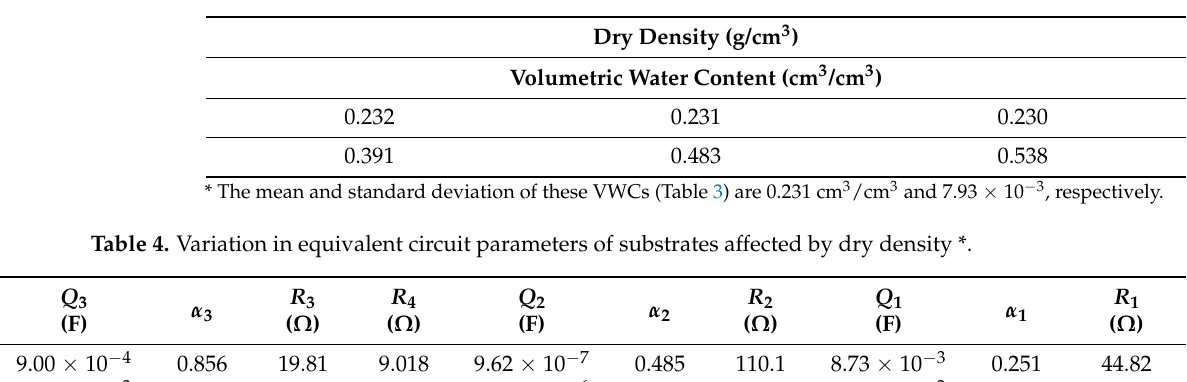
Figure 6. Impact of changes in dry density on measured complex conductivity of substrate. ( a ) Nyquist plots; ( b ) magnitude spectra; ( c ) phase spectra; ( d ) in-phase conductivity spectra; ( e ) quadrature conductivity spectra. For the spectra marked by different colors, the variable dry densities are provided in ( a ), while the related volumetric water contents (Table 3) are considered to be nearly equal. The frequency range is from 20 Hz to 2 MHz. Table 3. Dry densities of a typical set of substrates at nearly equal volumetric water contents *.